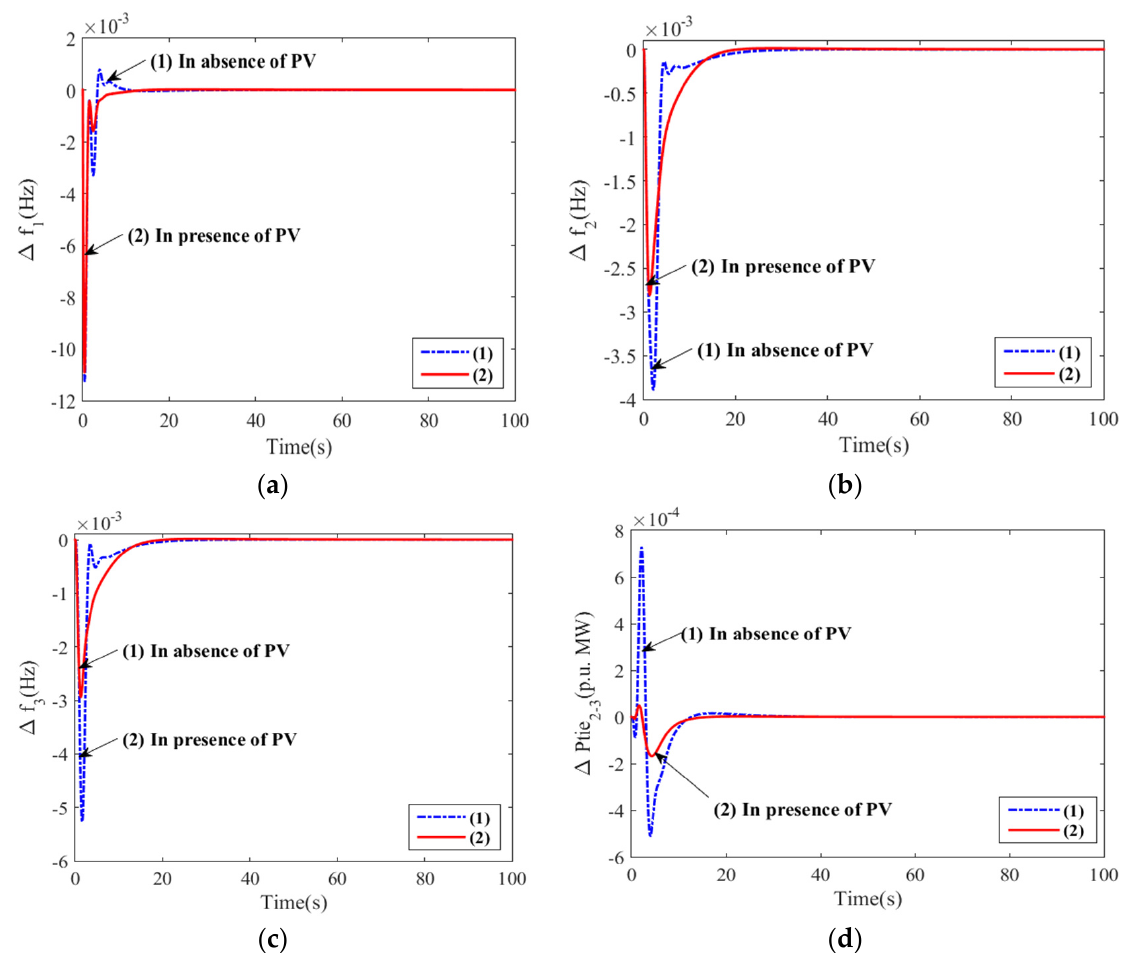
Figure 9. Valuation of influence of PV on system changing aspects employing SHO-optimized PDN(FOID) controller given 1% step load disturbances for system-3 contrast time : ( a ) Anomaly of frequency in area-1, ( b ) Anomaly of frequency in area-2, ( c ) Anomaly of frequency in area-3, ( d ) Anomaly of Tie-line power interlinking area-2 and area-3. Table 6. Finest values of gains and related parameters of PDN(FOID) controllers for scheme-3.